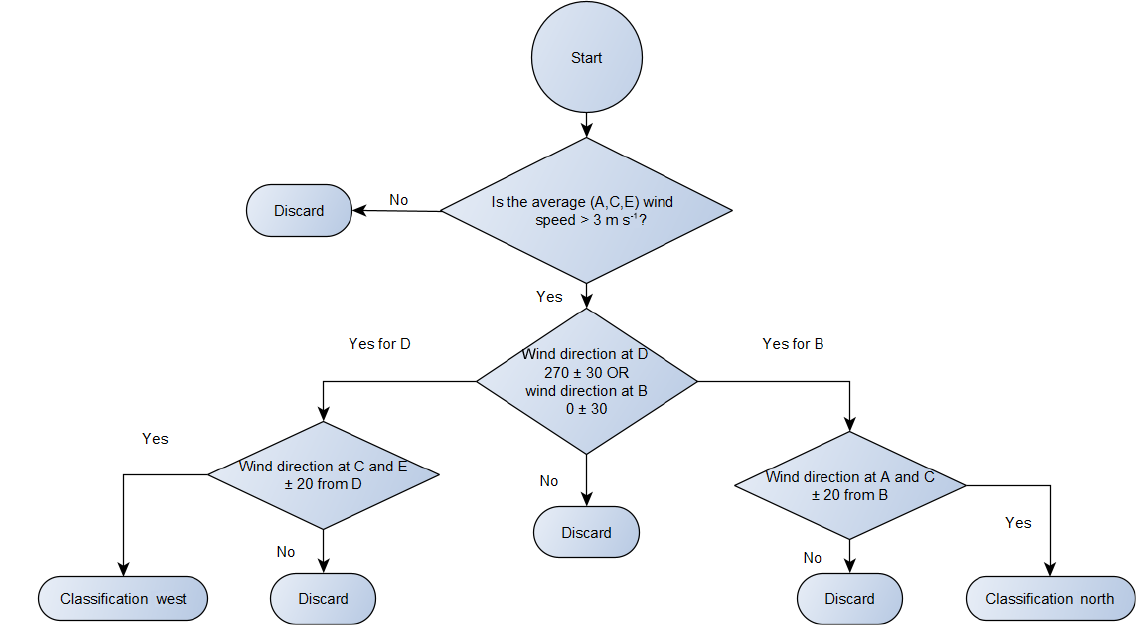
Figure 9. Flow chart for selection of cases classified as winds from northern and western